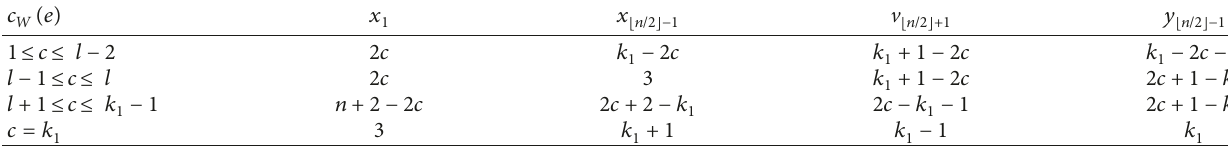
y c is even. c c , when